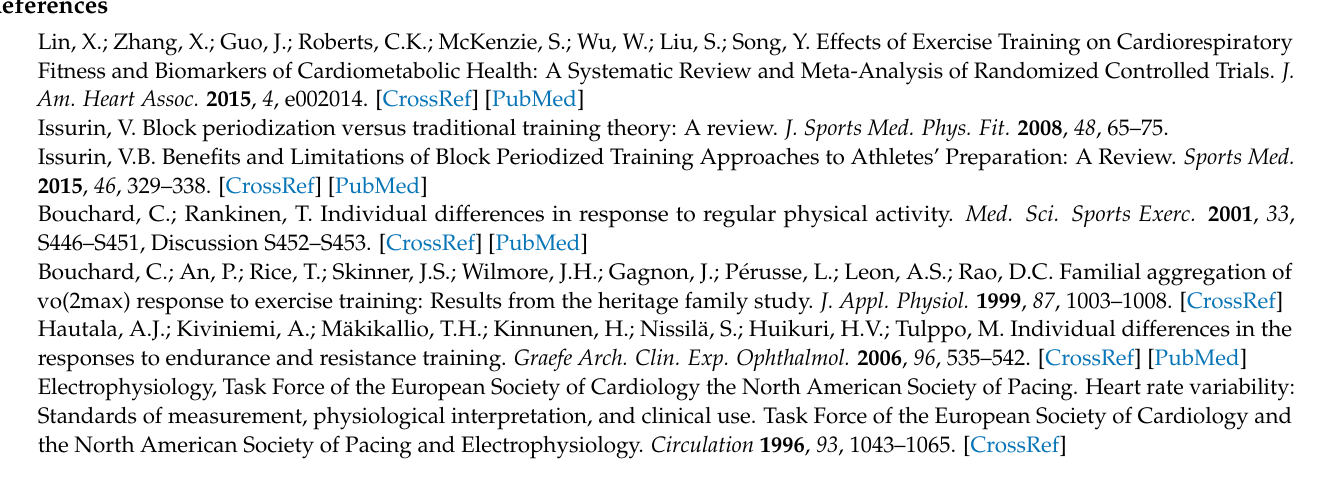
assessment criteria, Table S2. Risk of bias across studies, Section S3: Figure S1. Funnel plot with trim-and-fill method for standing vagal-related heart rate variability indices, Figure S2. Funnel plot with trim-and-fill method for standing heart rate, Figure S3. Funnel plot with trim-and-fill method for . VO 2 max, Figure S4. Funnel plot with trim-and-fill method for maximal aerobic capacity, Figure S5. Funnel plot with trim-and-fill method for aerobic capacity at second ventilatory threshold, Figure S6. Funnel plot with trim-and-fill method for aerobic capacity at first ventilatory threshold, Figure S7. Funnel plot with trim-and-fill method for endurance